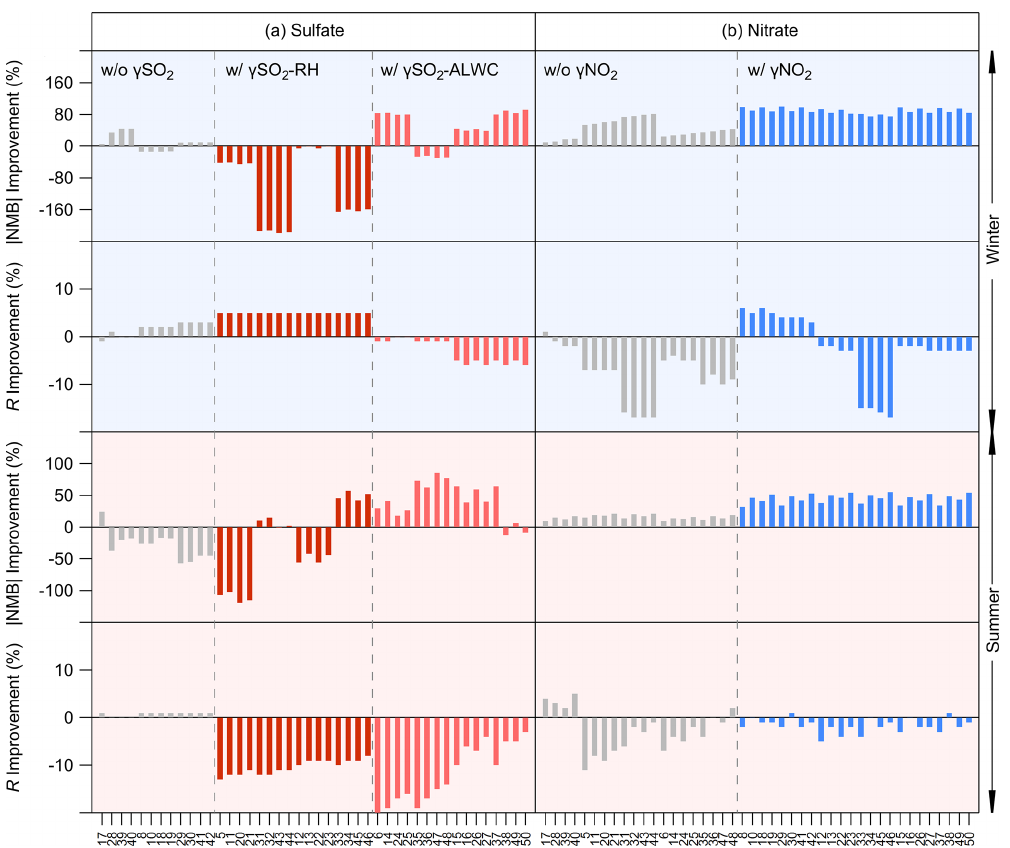
Figure 7. The improvements of the R and the | NMB | values for (a) sulfate and (b) nitrate in Cases 10–50 relative to Case 0 (standard) during the selected wintertime and summertime periods. For comparison, Cases 5 (with γ SO also plotted. Positive values in | NMB | or R improvement mean improved